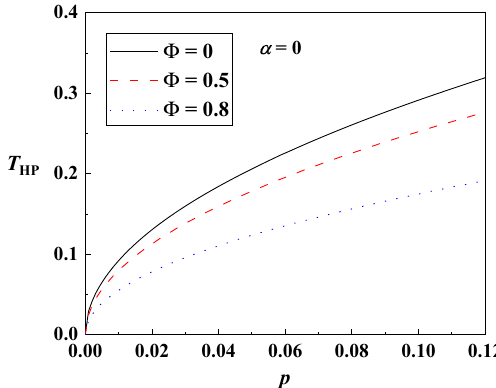
Fig. 5 The Gibbs free energy of large Schwarzschild–AdS black holes as a function of temperature, with a fixed pressure p = 1 /( 48 π) and different values of α . All the G – T curves start from the same minimal √ temperature T 0 = 1 /( 2 6 π) and move downward with α increasing, so T HP decreases with α